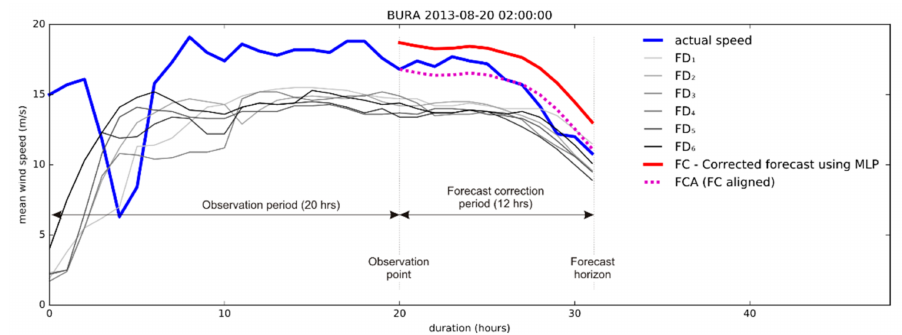
Figure 11. An example of the corrected 12 h forecast.